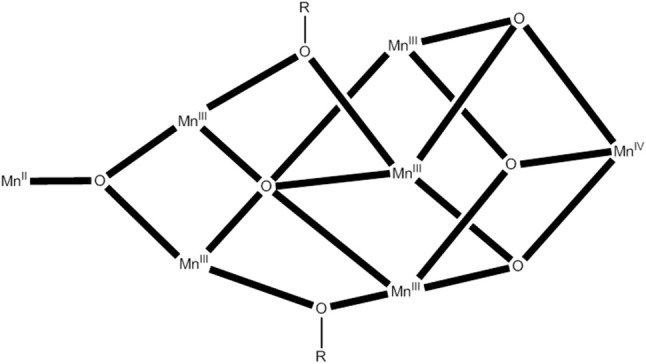
The novel manganese-oxygen core of complex 10; coordination bonds are drawn in bold. R– = PhCH2- (Schematic drawing inspired by Mishra et al., 2006).